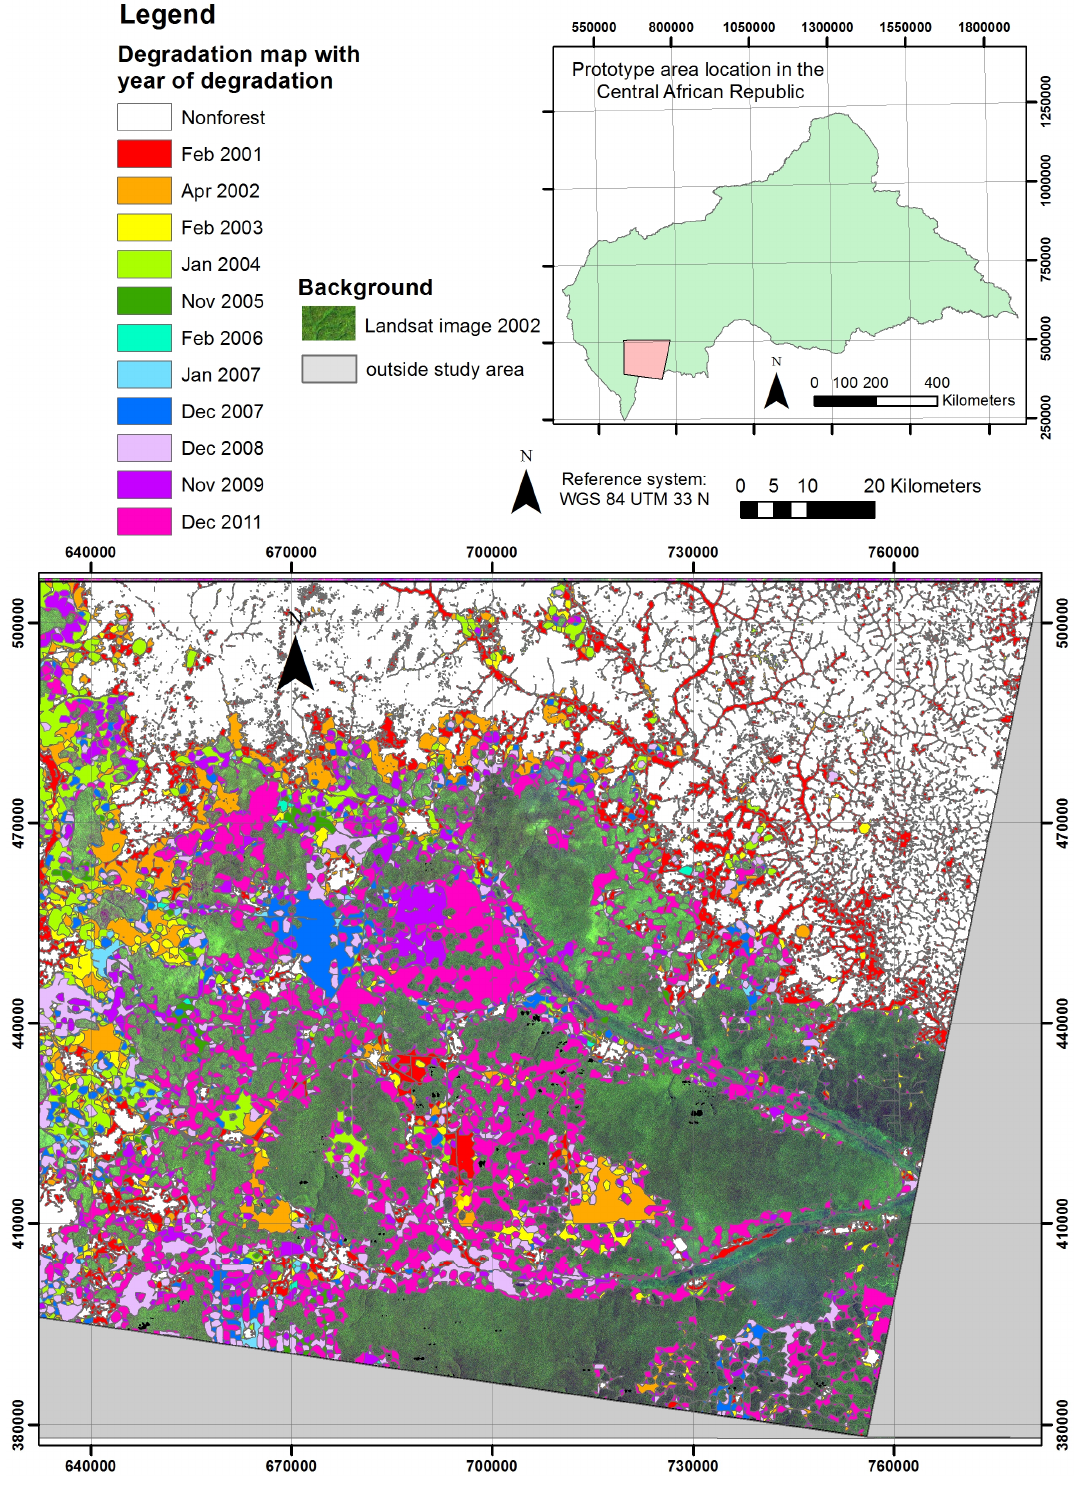
Figure 6. Final degradation map for CAR study site. The different colors indicate the time of (first) degradation